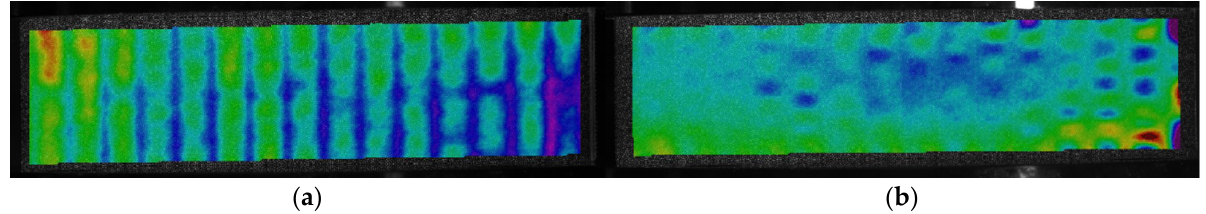
Figure 17. The ECT sample during the CD test: ( a ) sample during the CD test–no buckling; ( b ) sample during the CD test–